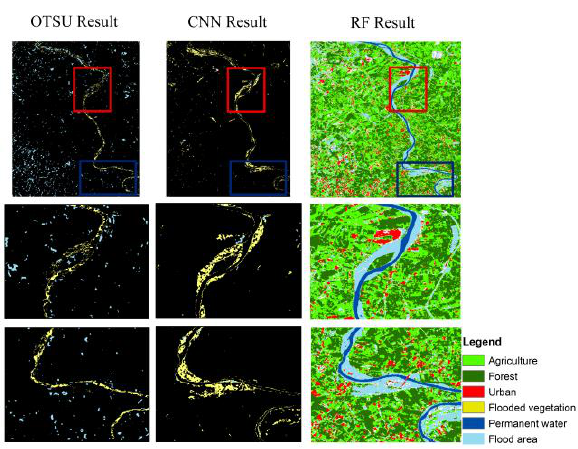
Figure 7 . Results of around the Yesilirmak River, Ordu,